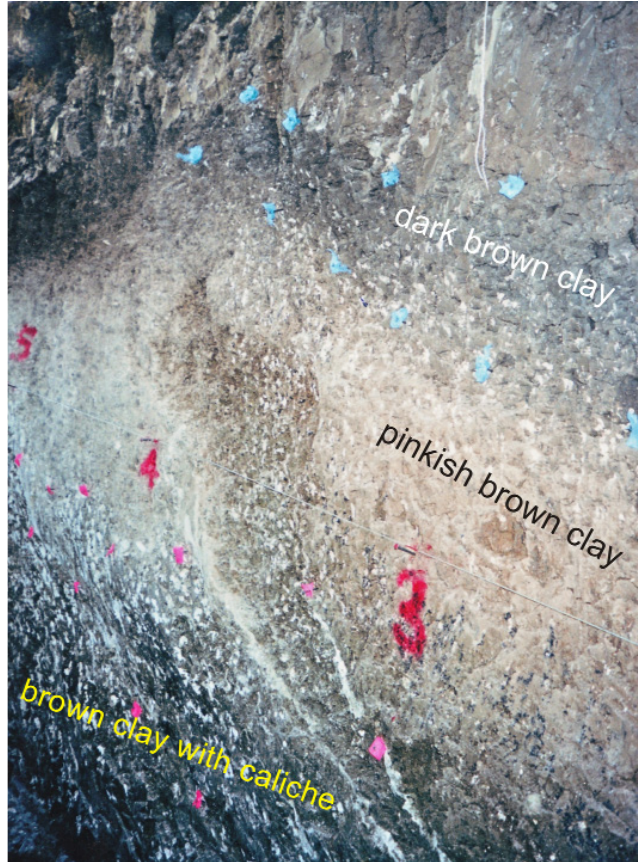
Figure 9. General view of Trench-3. Note that caliche fills make the sliding surfaces more